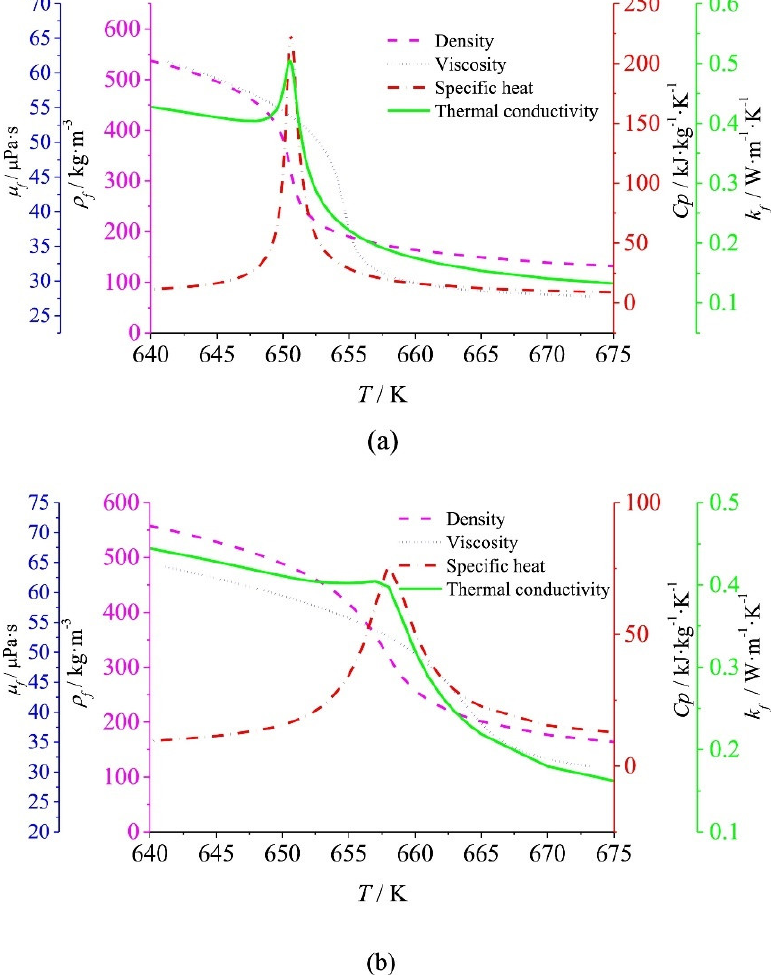
Figure 1. Physical properties of water near the critical point at ( a ) 23 MPa and ( b ) 25 MPa [21]. Reprint with permission from ref. [21]. Copyright 2018 Elsevier.